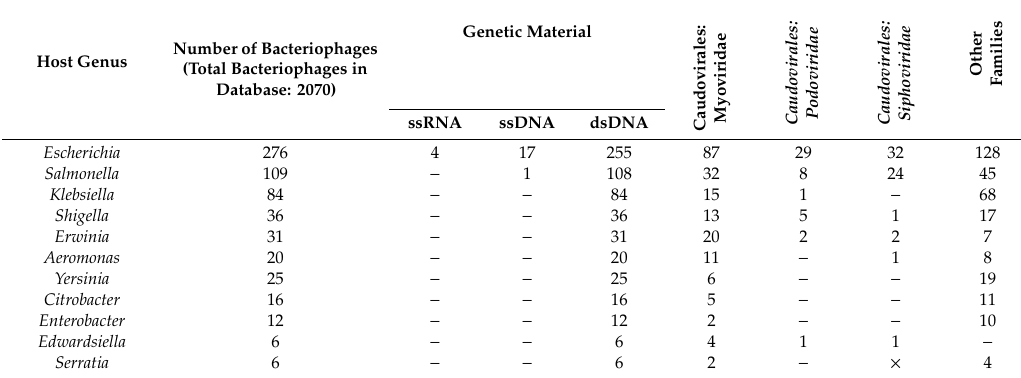
Table 1. Number of bacteriophages classified by ICTV for some Gram negative enteric bacterial genera. Information taken from Virus Metadata Repository: May 1, 2020 version; MSL35